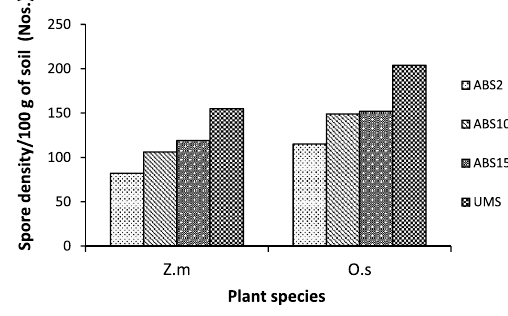
Fig. 2. AMF spore density in trap culture set up with study sites derived inocula where Zea mays L. (Z.m) and Oryza sativa L. (O.s) are used as trap